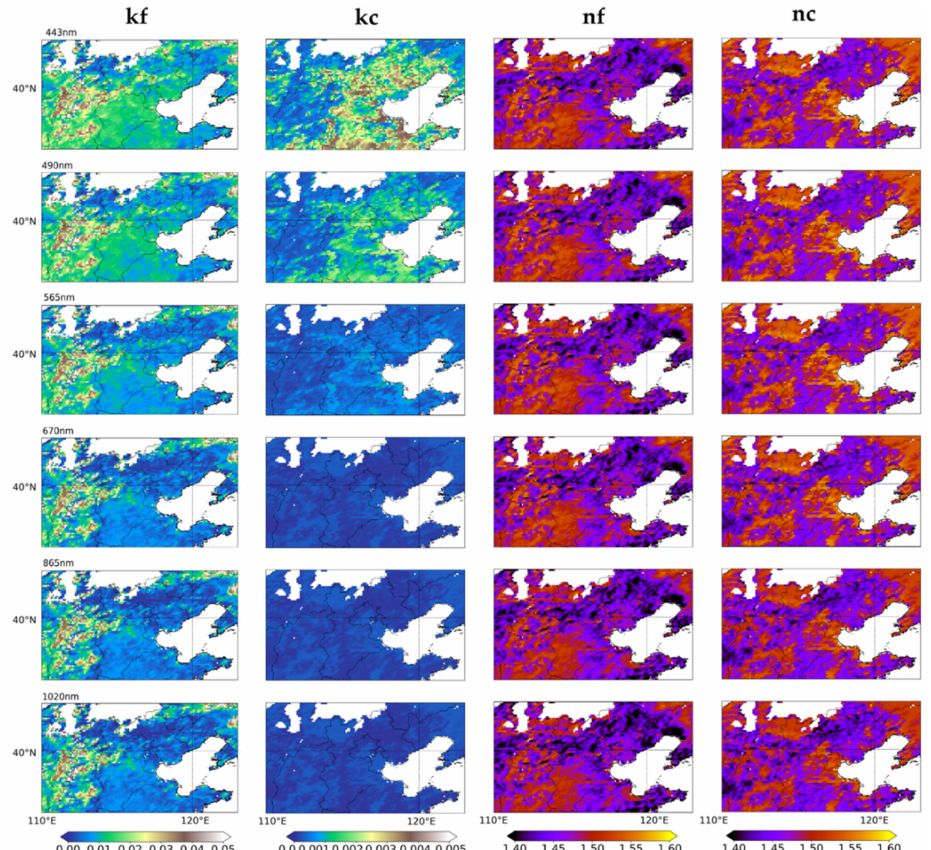
Figure 5. Monthly imaginary refractive index of fine mode (k f ) and coarse mode (k c ), real refractive index of fine mode (n f ) and coarse mode (n c ) at 443, 490, 565, 670, 865, 1020 nm in January 2012 as retrieved from POLDER-3/PARASOL satellite